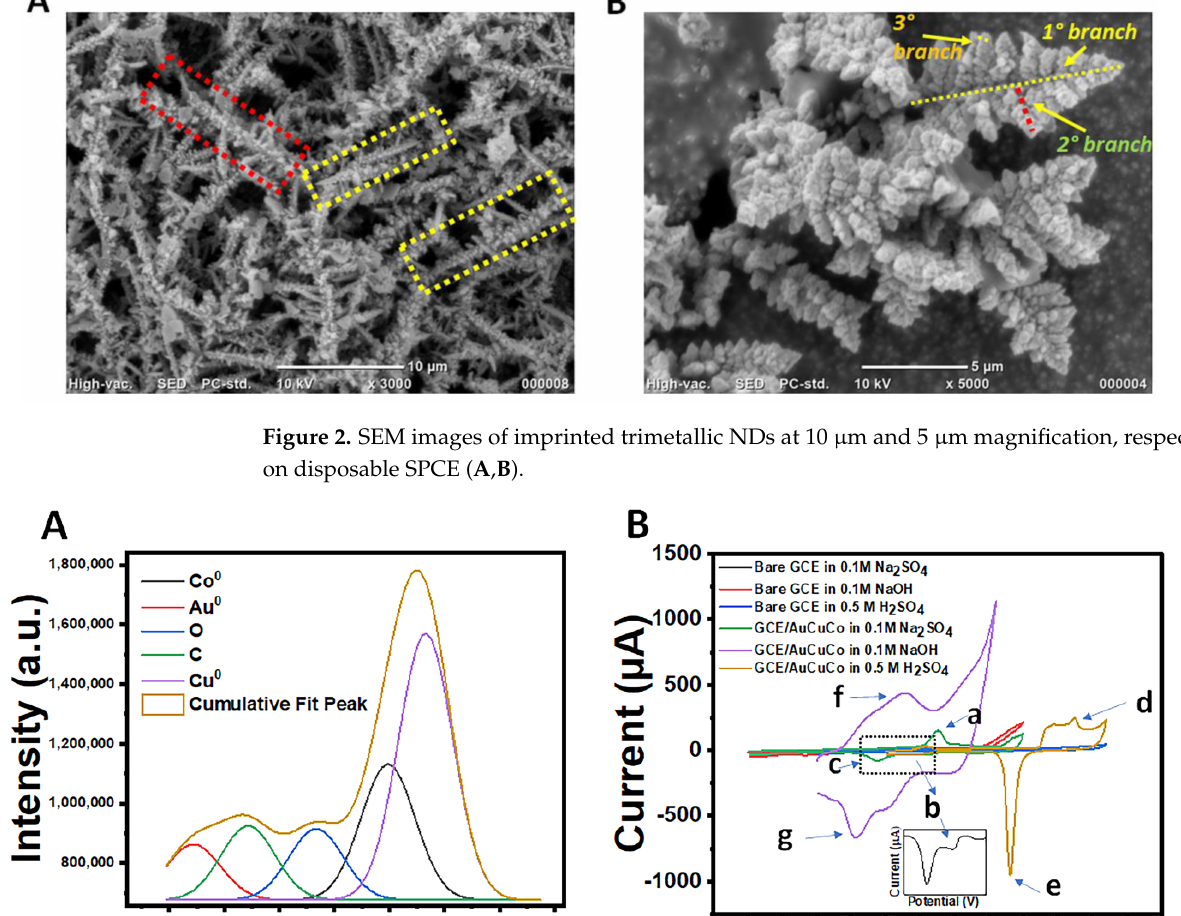
Figure 2. SEM images of imprinted trimetallic NDs at 10 µm and 5 µm magnification, respectively, on disposable SPCE ( A , B